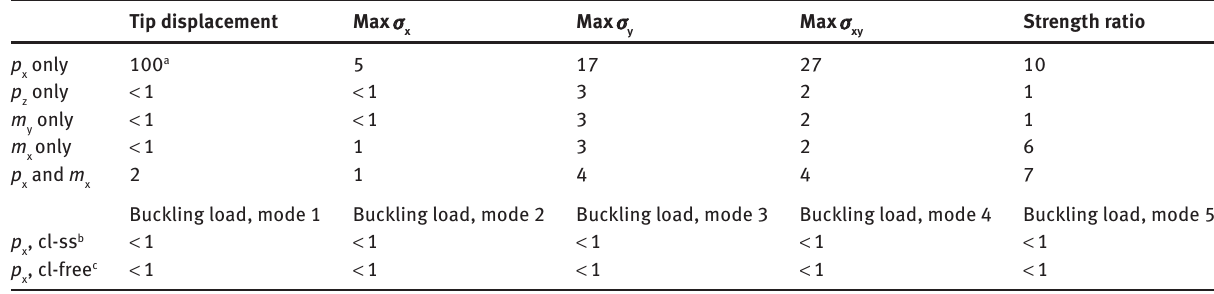
thin-ply NCF (C-ply/epoxy) flat laminate example: percent errors due to the use of homogenized laminate Table 4: Clamped-free [0/25] 16 T properties relative to ply-by-ply